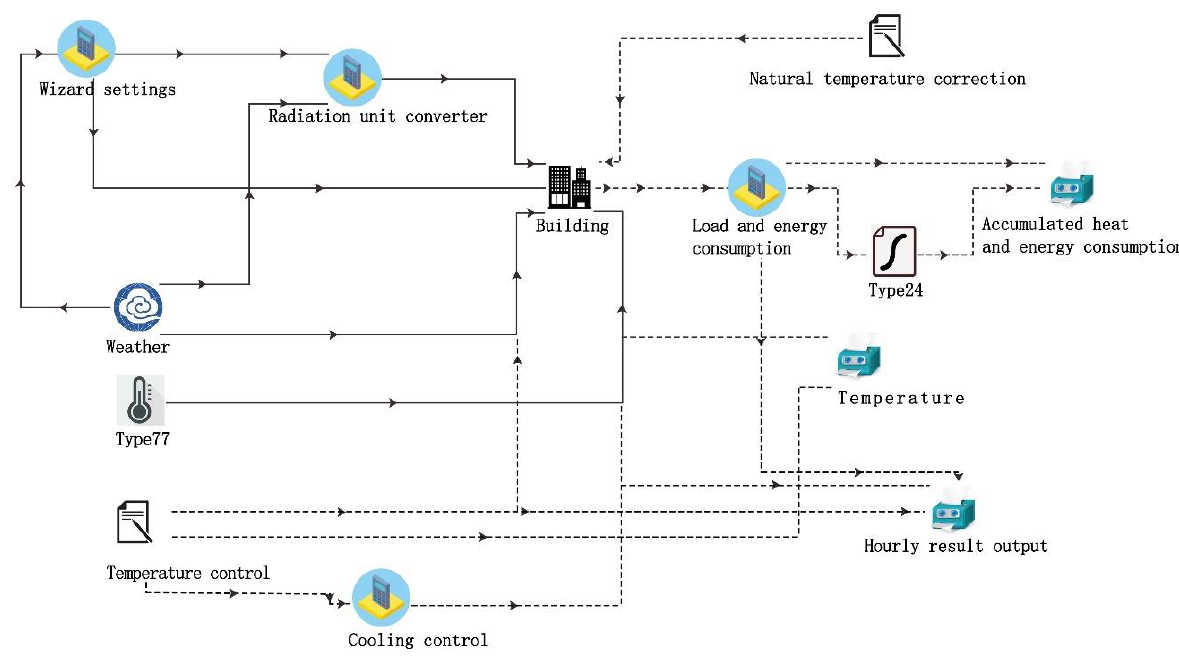
Figure 8. The schematic diagram of the TRNBuild module.